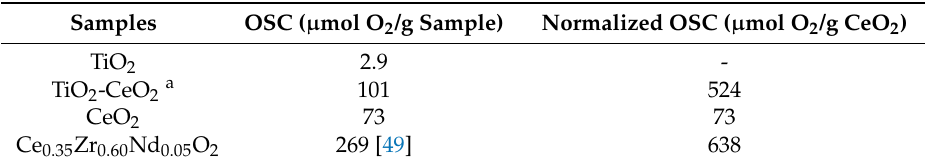
Table 4. The oxygen storage capacity (OSC) of TiO 2 , TiO 2 -CeO 2 and CeO 2 -based catalysts.